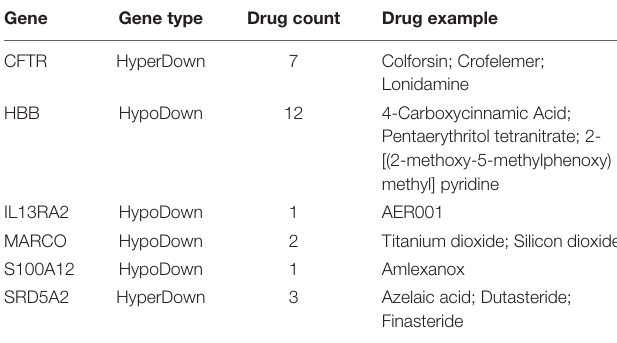
TABLE 1 | The interaction between DMEGs and